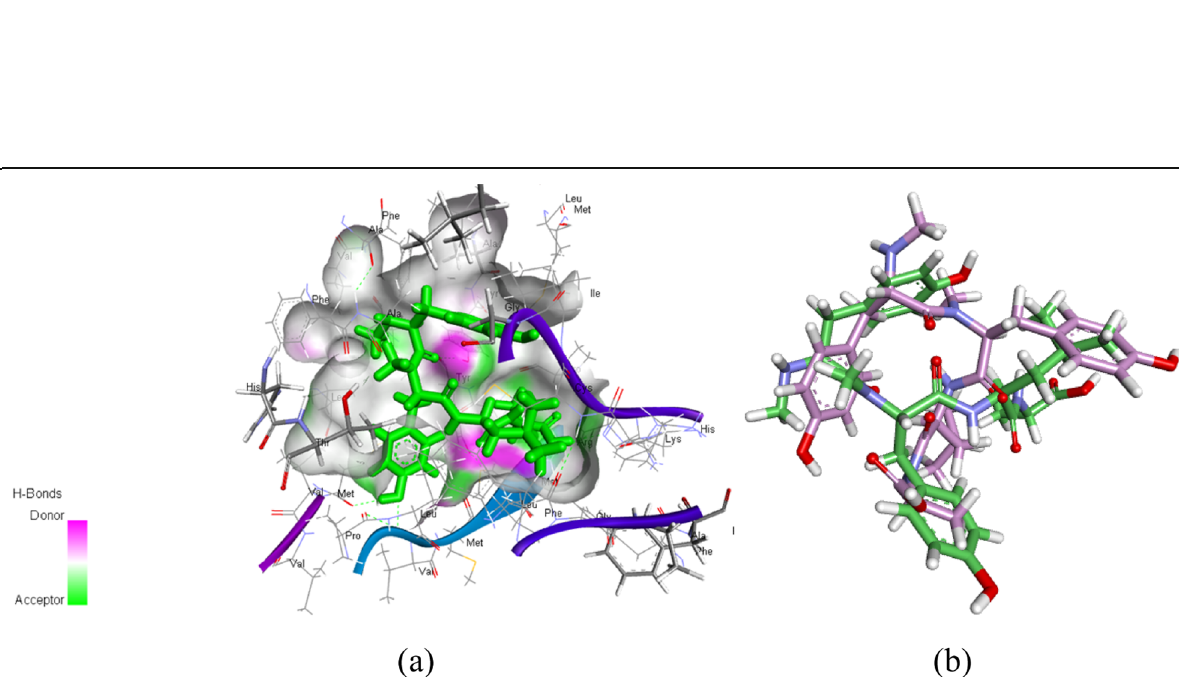
Fig. 10 a Orientation of UNPD86509 in binding site of CYP51. b Ligand state alignment pre simulation (green) and post simulation